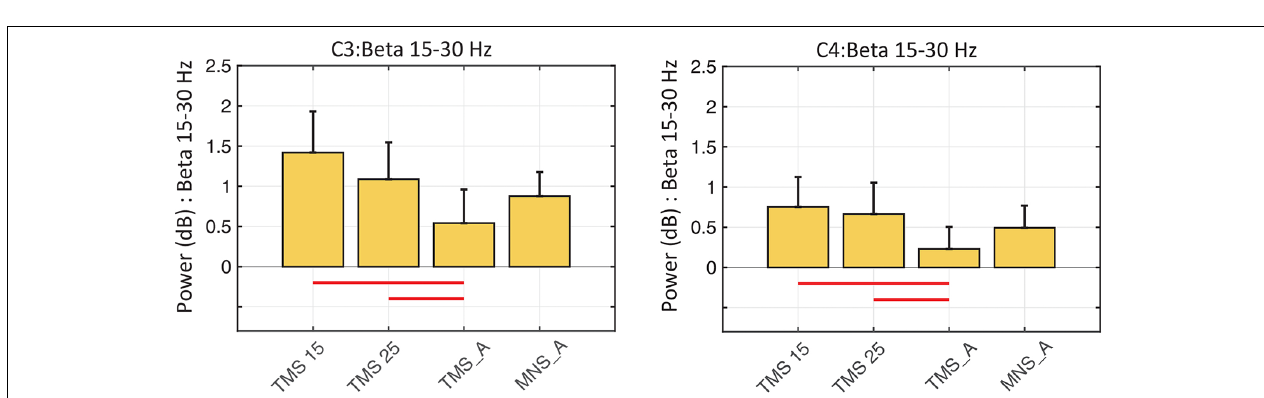
FIGURE 4 | ERSPs for electrode C3. The power spectra between 5 and 30 Hz are shown for all experimental conditions (upper left: MNS + TMS15, upper right: MNS + TMS25, lower left: TMS_A, and lower right: MNS_A). Frequency bands (lower, middle, and upper beta) and time window of interest (from 500 to 1,000 ms; used thereafter for statistical comparisons) are represented by three rectangles.